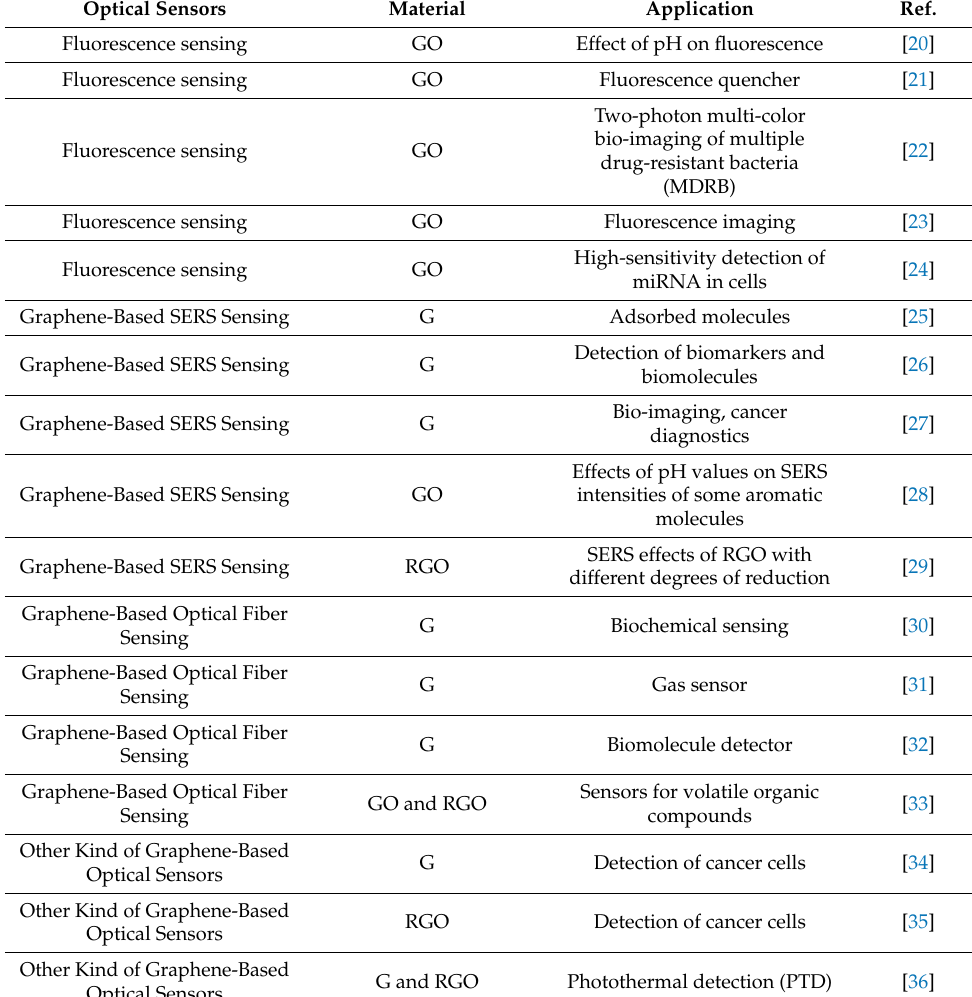
Table 1. Several applications of graphene and its derivatives-based optical sensors. Optical